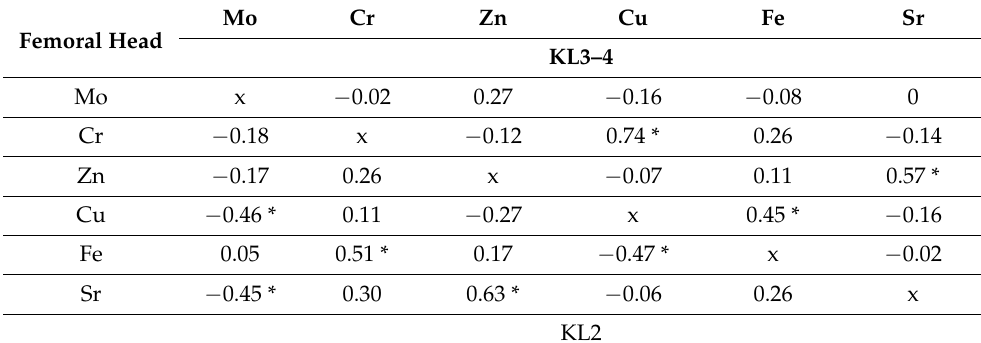
Table 3. Spearman’s correlation coefficients for the metals found in the femoral head for mild and severe grades of osteoarthritis